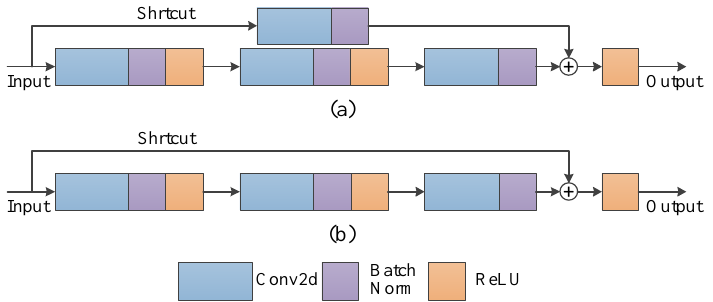
Figure 2. Residual block of ResNet50. ( a ) first layer structure of residual body. ( b ) subsequent structure of residual body.